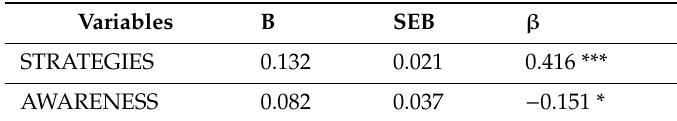
Table 7. Standard multiple regression analysis summary for variables predicting the instability coe ffi cient ( ∆ ).